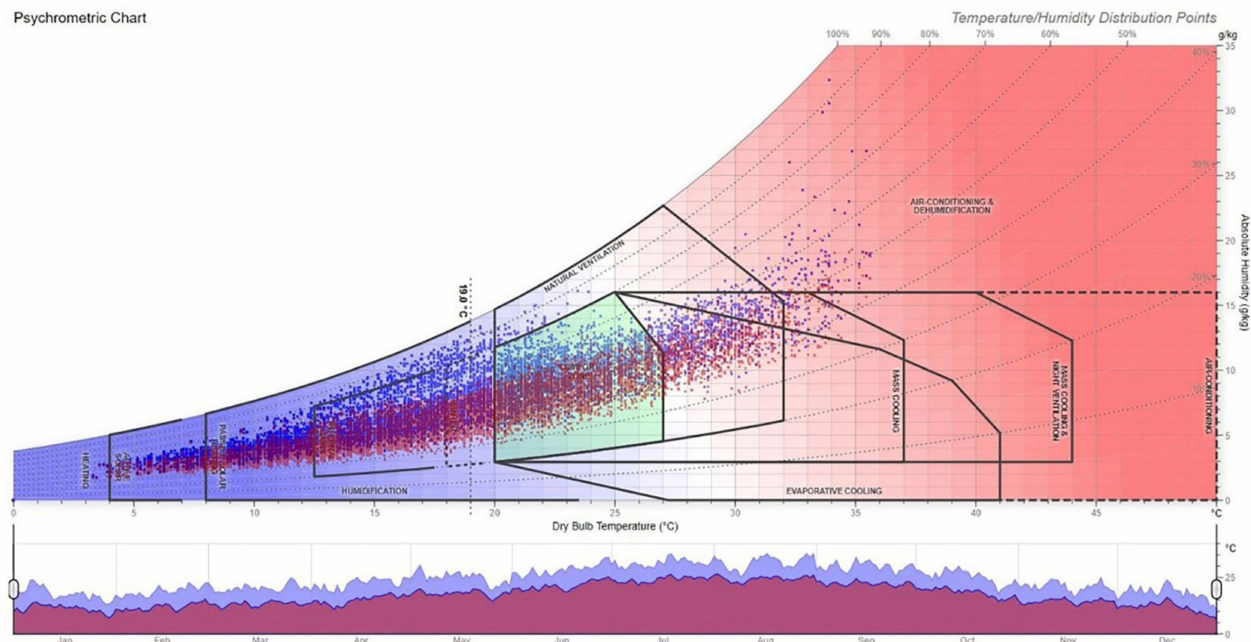
Figure 17. Givoni Bioclimatic Chart: existing building (no insulation) in blue; and existing building (with insulation) with a shading system installed on the south-east and south-west elevations in red.